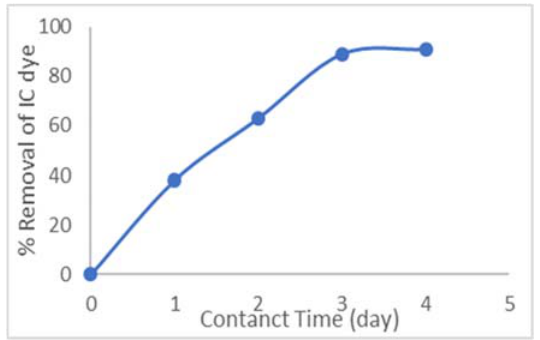
Fig. 8. Contact time effect on the removal of IC dye at 30 o C, 10 ppm dye concentration and 0.25 gm adsorbent dosage.